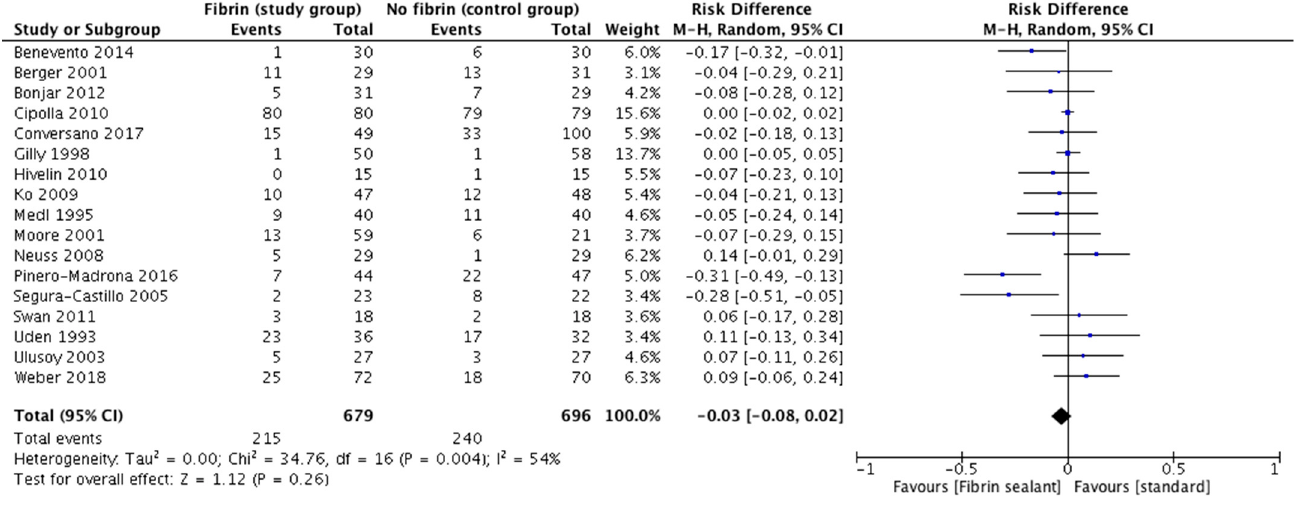
Figure 2. Axillary lymphocele.